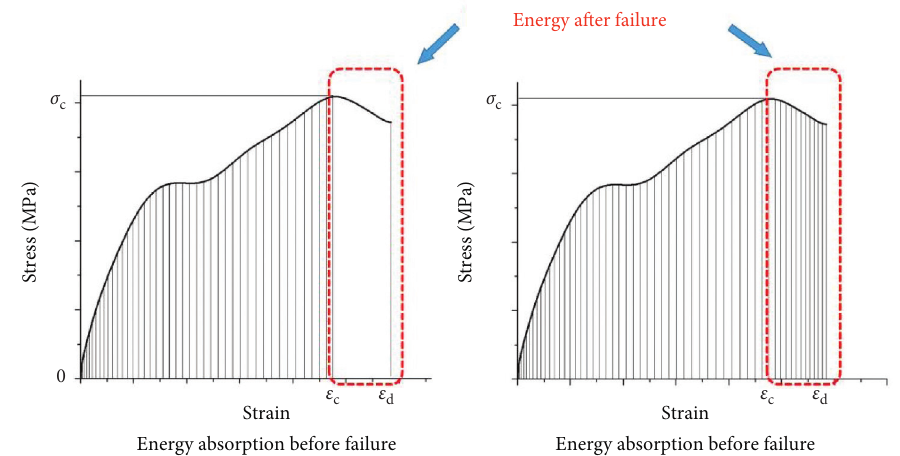
Figure 8: Energy absorption of the PVC/PVDF